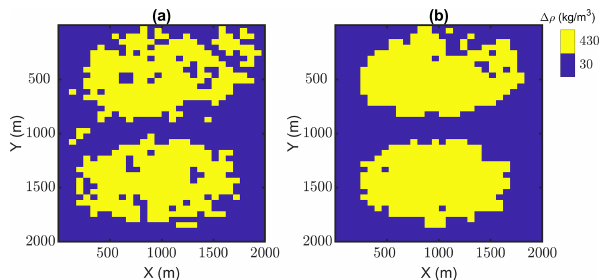
Figure B1. Top view of the hard-rock synthetic example at the depth of 150m. Panels (a) and (b) show the results of the uncon- strained inversion without applying the morphological closing to the model and after applying the morphological closing constraint,